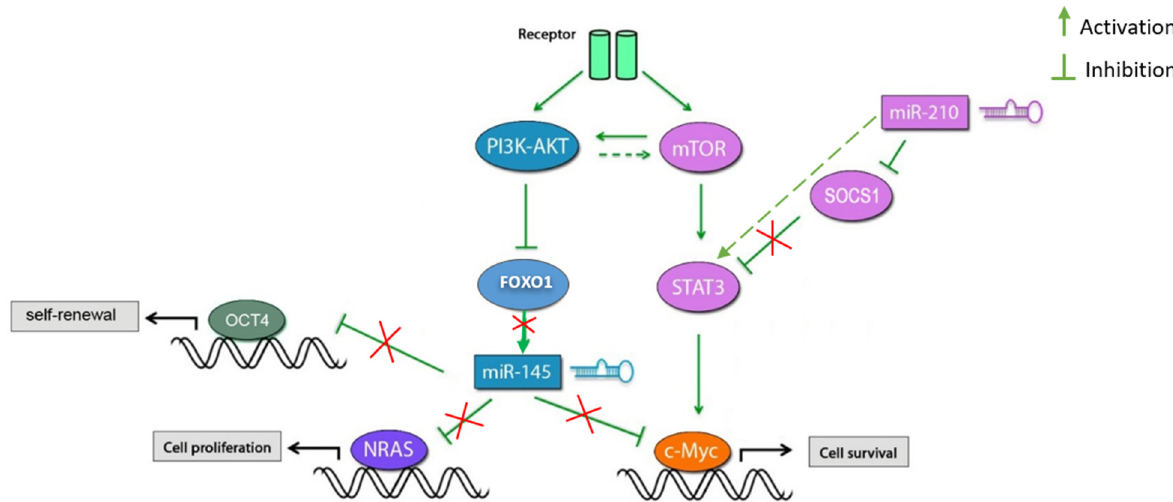
Figure 6. The potential mechanism of action of miR-145 and miR-210 in cancer cells. PI3k/AKT signaling is often constitutively activated in cancer. Inactivation of FOXO1 and subsequent inhibition of miR-145 expression by the PI3K/AKT pathway favors cell survival, proliferation, and expansion of the CSC population and increases self-renewal and tumorigenic capacity. Activation of STAT3 induces cancer cell survival by inducing the expression of c-Myc. miR-210 inhibits SOCS1 and activates the STAT3 pathway favoring cell survival.